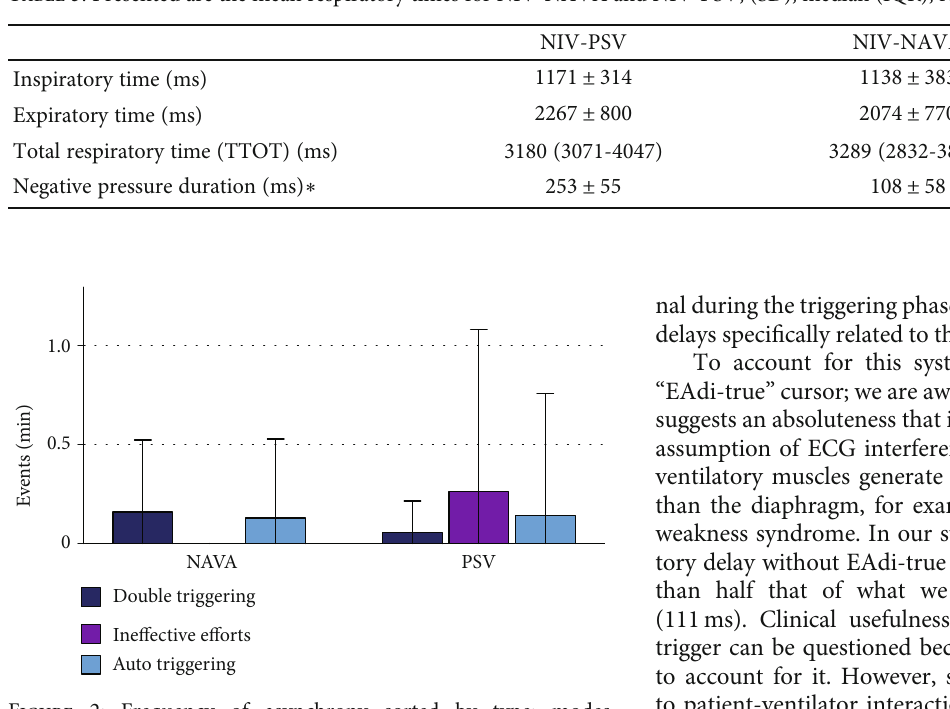
Table 3: Presented are the mean respiratory times for NIV-NAVA and NIV-PSV, (SD), median (IQR), respectively; ∗ signi fi cant di ff erence.